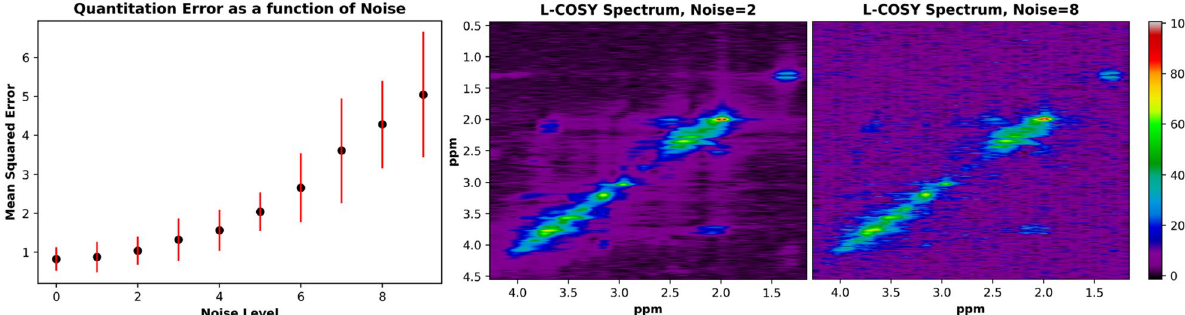
Figure 7. The mean squared error is displayed as a function of noise level for the quantitation D-UNet results (left). These results were produced by analyzing MSE for 100 identical spectra at 10 different noise levels ranging from 0 to 25% noise relative to the maximum signal intensity. Two example spectra are shown displying 5% noise (middle) and 20% noise (right). Qualitatively, it is clear that cross-peak signal amplitude is greatly altered due to the added noise in the noise level = 8 spectrum.